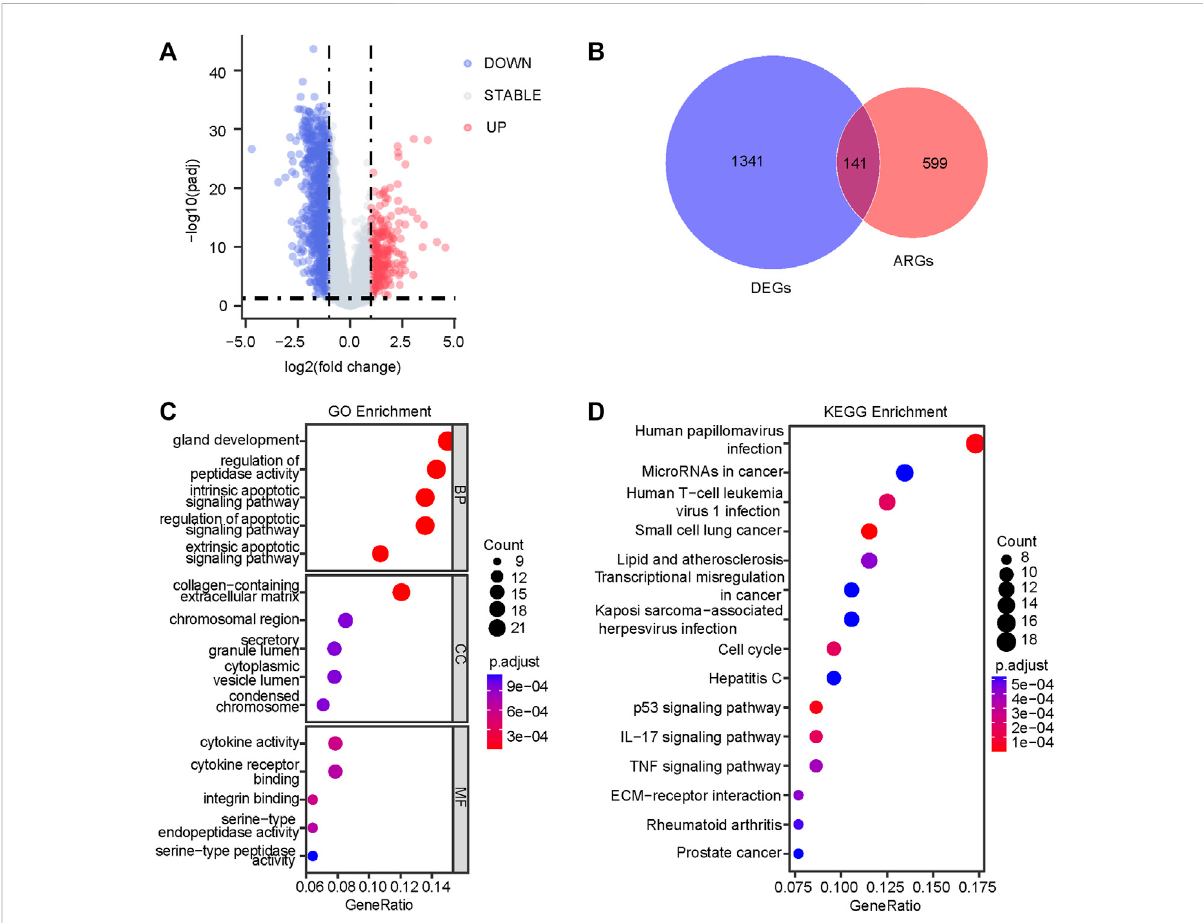
FIGURE 2 Identi fi cationoftheanoikis-relatedprognosticgenes. (A) ThevarianceanalysisbetweentumorandadjacentnormaltissuesintheTCGAdataset (|logFC| > 1.0, p.adj < 0.05). (B) The insection between 1482 DEGs and 740 ARGs isdisplayed bythe Venn diagram. The dot plots of GO (C) and KEGG (D) enrichment analysis are based on 141 anoikis-related DEGs. TCGA, The Cancer Genome Atlas; DEGs, differentially expressed genes; ARGs, anoikis-related genes; GO, Gene Ontology; KEGG, Kyoto Encyclopedia of Genes and